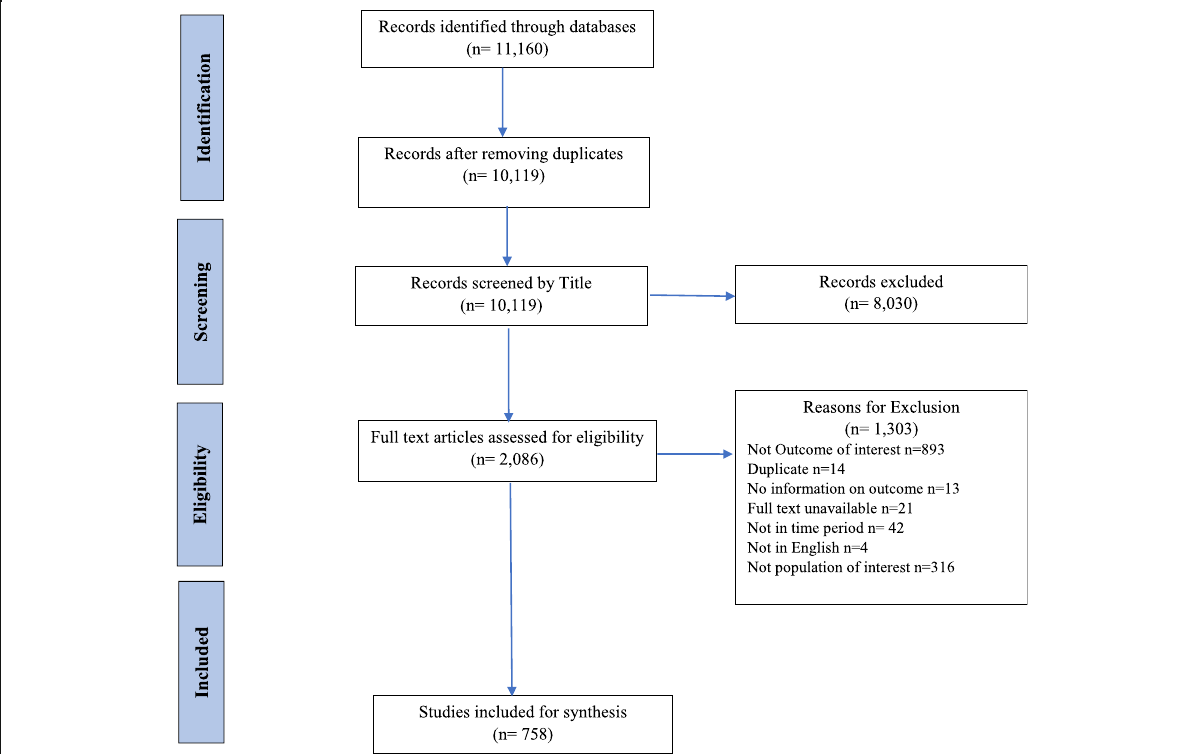
Fig. 1 Flow of Studies According to PRISMA Flow